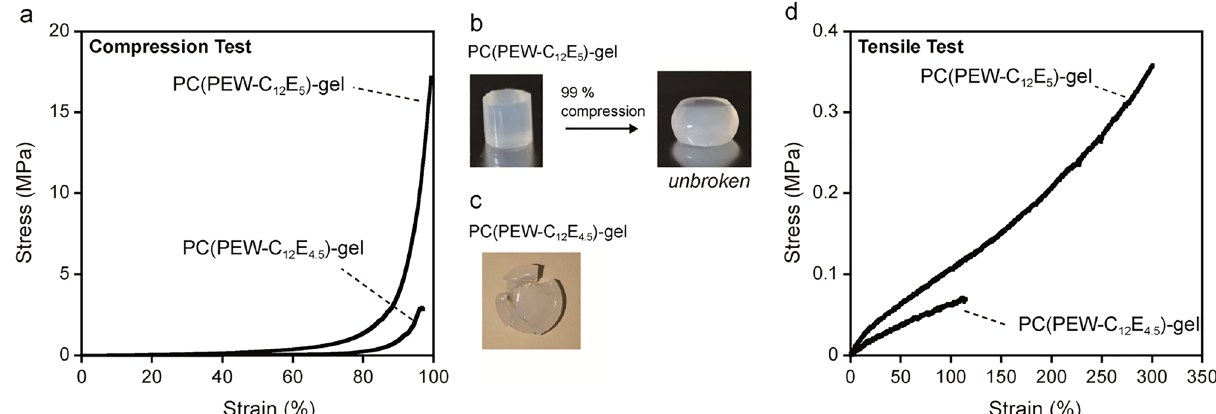
Figure 5. Mechanical properties of PC(PEW)-gel prepared with monodisperse C 12 E 5 and polydisperse C 12 E 4.5 surfactants prepared at 70 °C. ( a ) Compressive stress–strain curve. ( b ) PC(PEW-C 12 E 5 )-gel before and after 99% compression, showing non-destructive property against compression ( c ) destructed PC(PEW-C 12 E 4.5 )-gel after 96% compression ( d ) Tensile stress–strain